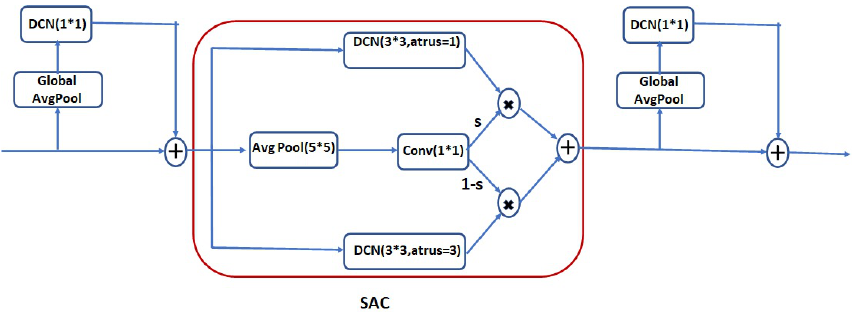
Figure 8. Tassel